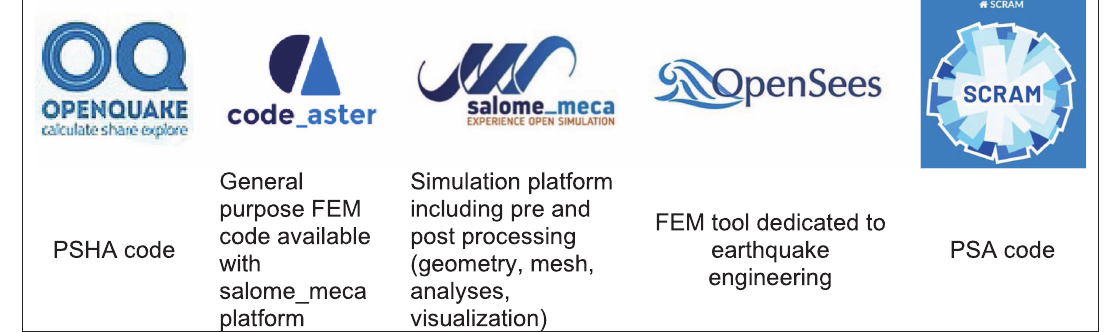
Fig. 2. Existing open-source codes used and developed by